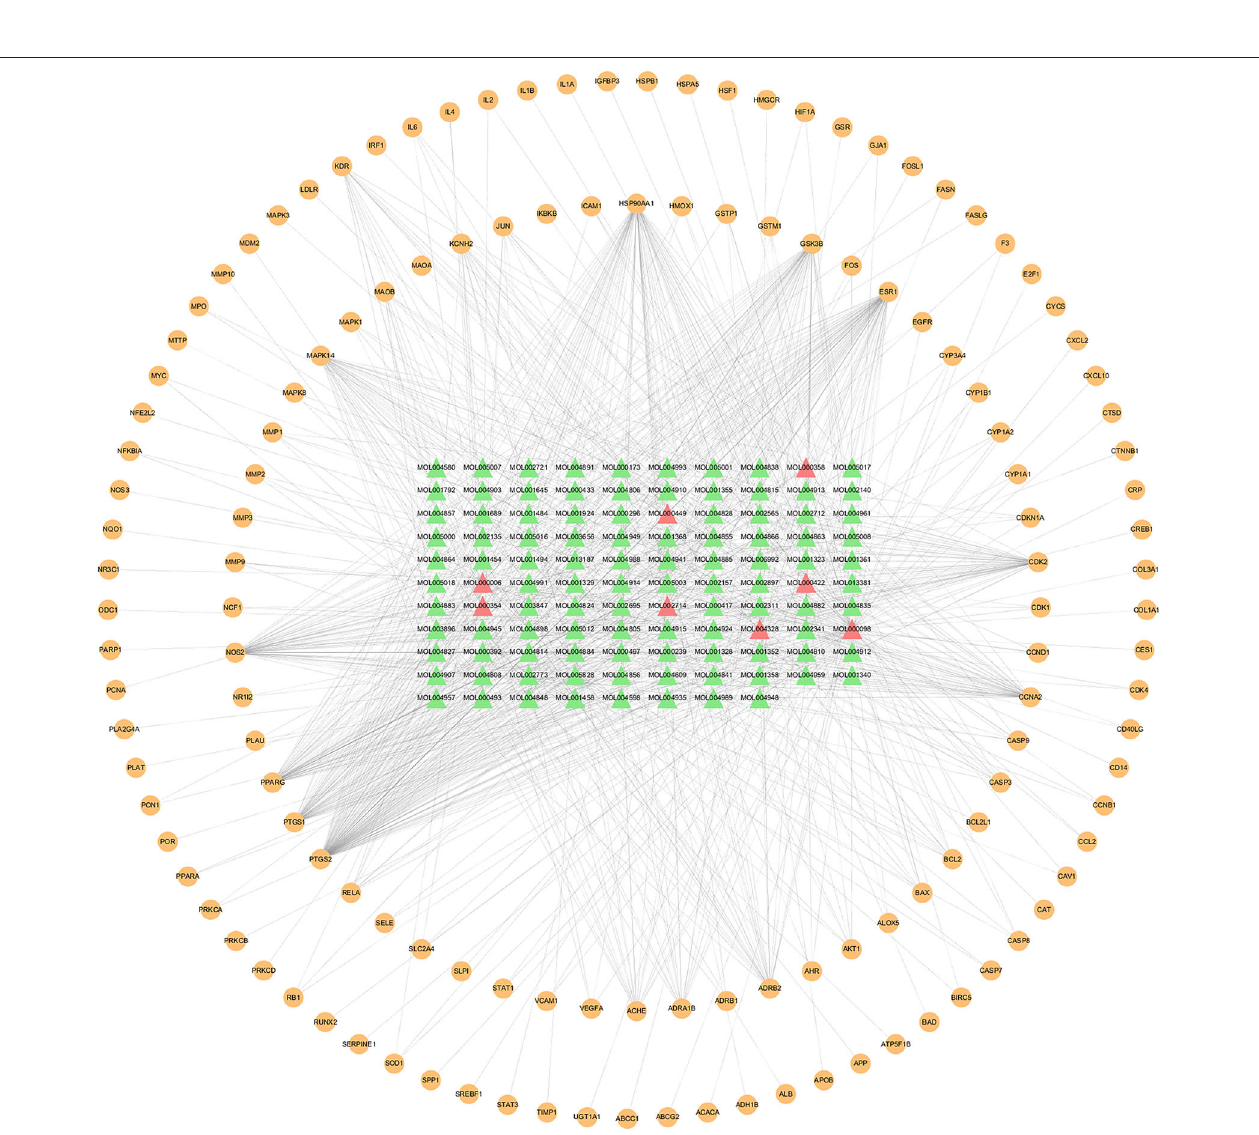
FIGURE 2 | Compounds–targets network of Xuefu Zhuyu decoration (XFZYD) in treating ASCVD. Orange ellipse nodes represent potential therapeutic targets, green triangle nodes represent effective compounds, and red triangle nodes represent the effective compound originated from multiple herbs.